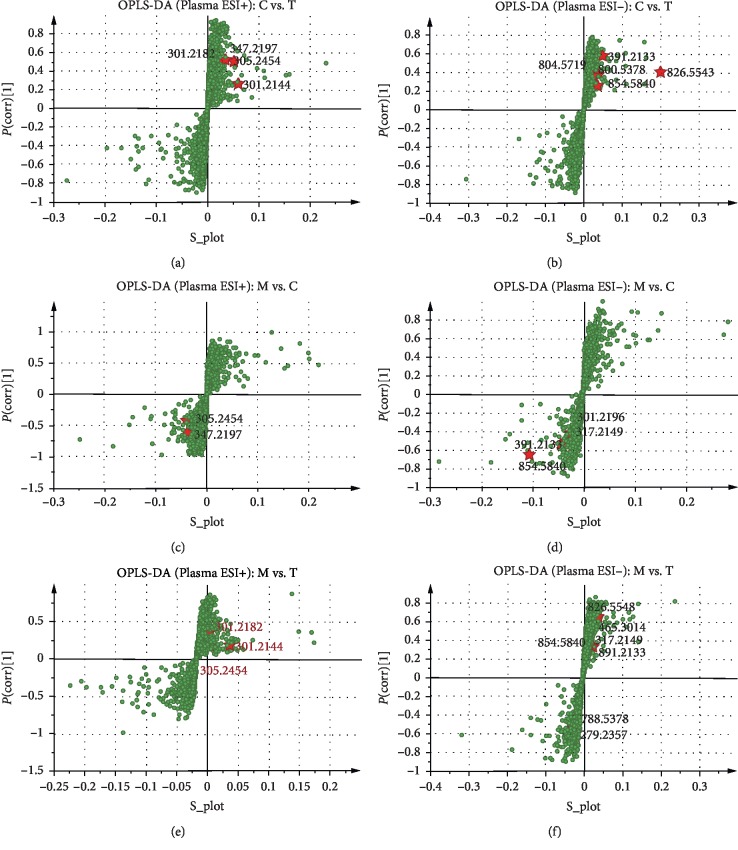
OPLS-DA S-plots of metabolomics analysis based on plasma samples. All differential metabolites are shown in S-plots, including the identified results between the control group and the RWCI treatment groups in the ESI+ mode (a) and in the ESI− mode (b), the identified results between the model group and the control group in the ESI+ mode (c) and in the ESI− mode (d), and the identified results between the model group and the RWCI treatment groups in the ESI+ mode (e) and in the ESI− mode (f). C: control group; M: model group; T: RWCI treatment groups. The p(corr)[1]-axis shows the reliability of each variable in X.